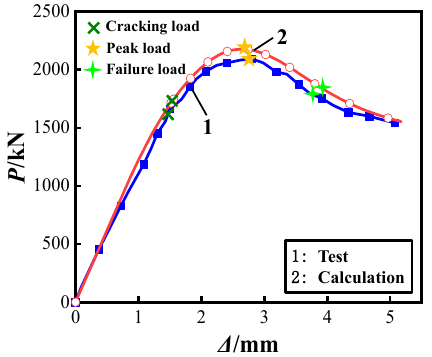
Figure 18. Comparison of load–displacement curves of specimen Z3.